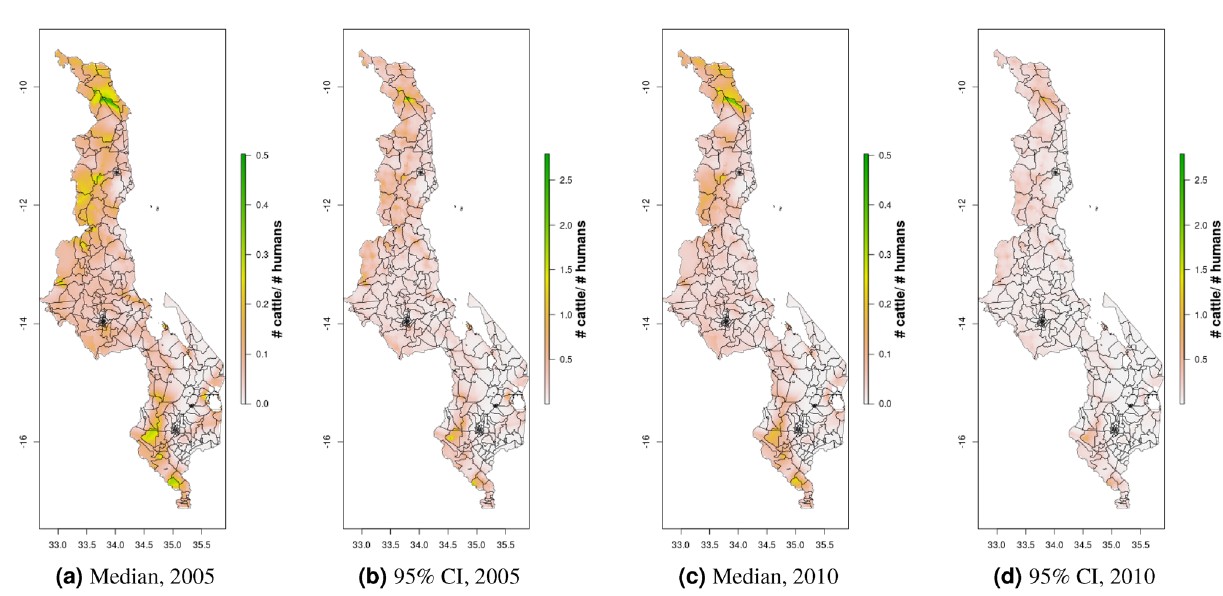
Figure 4. Cattle density mapping results, Malawi, 2005 and 2010. Median ( a, c ) and width of posterior 95% credible interval ( b, d